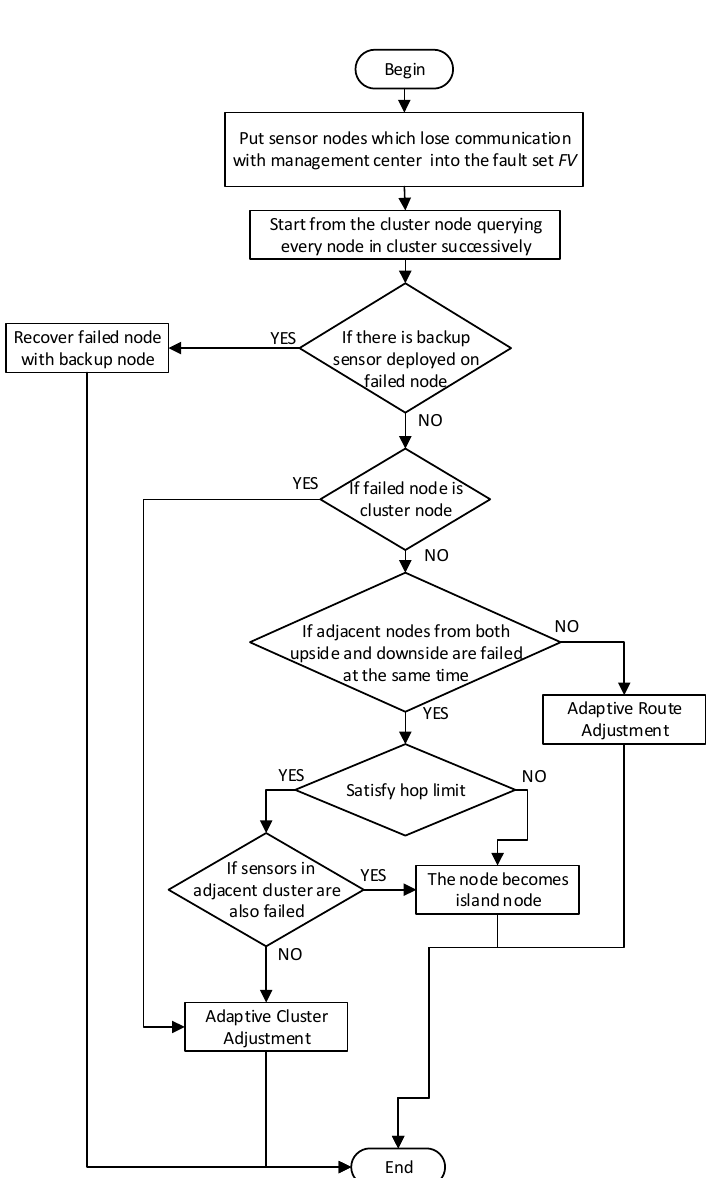
Figure 5. Illustration of cluster adjustment.